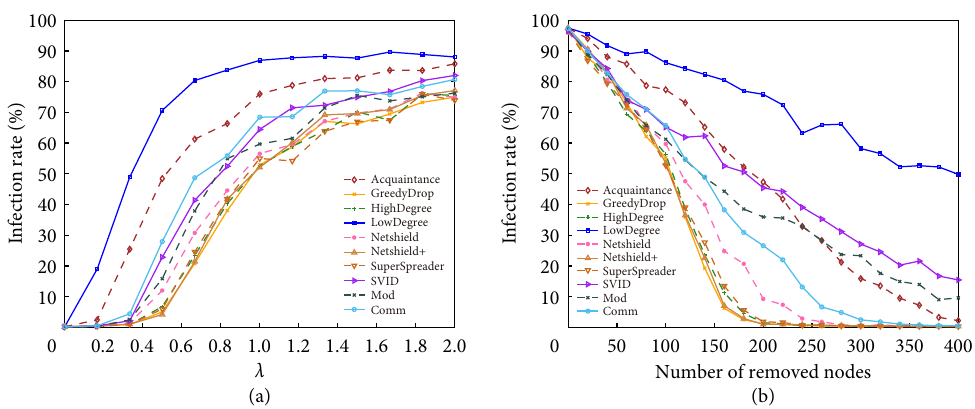
λ Fig. 2 (a) Comparition of algorithms with different . (b) Comparition of algorithms with different numbers of removed